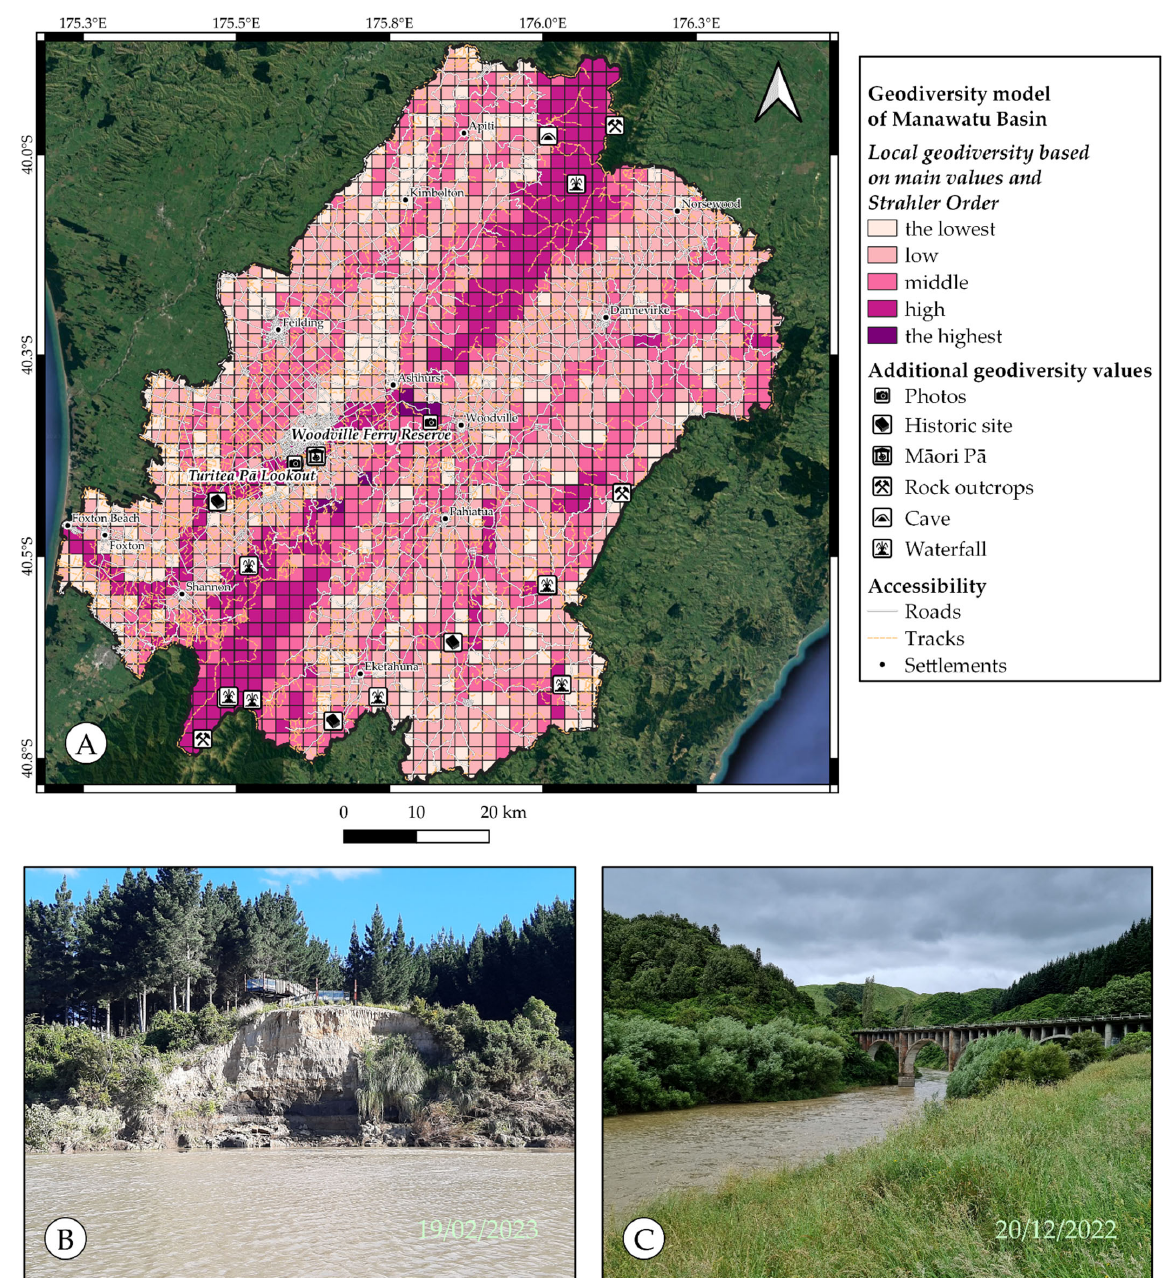
Figure 8. ( A ) Geodiversity model of Manawatu Basin with hydrological model and additional locations of geodiversity significance. Values were weighted specifically for local perspectives to highlight the locations of interest; ( B ) Turitea P ā Lookout; ( C ) Woodville Ferry Reserve. The role of rivers in geoheritage characterization and geodiversity estimates is still underutilized. There are only a few exceptions of recent works where the geological and geomorphological aspects of rivers are proposed to apply to a more widespread sense. These works, however, are very specific to major valley systems and their geology and